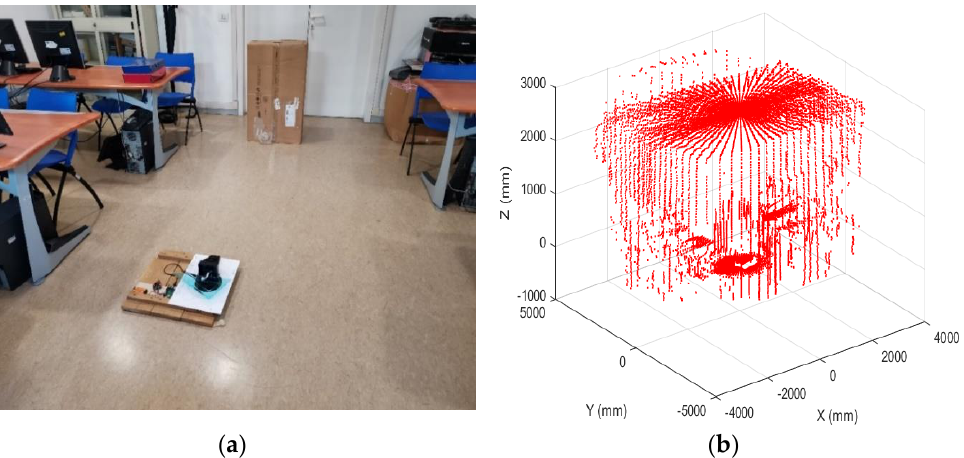
Figure 11. ( a ) Indoor experiment scenario (room dimensions: 6400 × 2890 mm); ( b ) 3D reconstruction from LiDAR data.